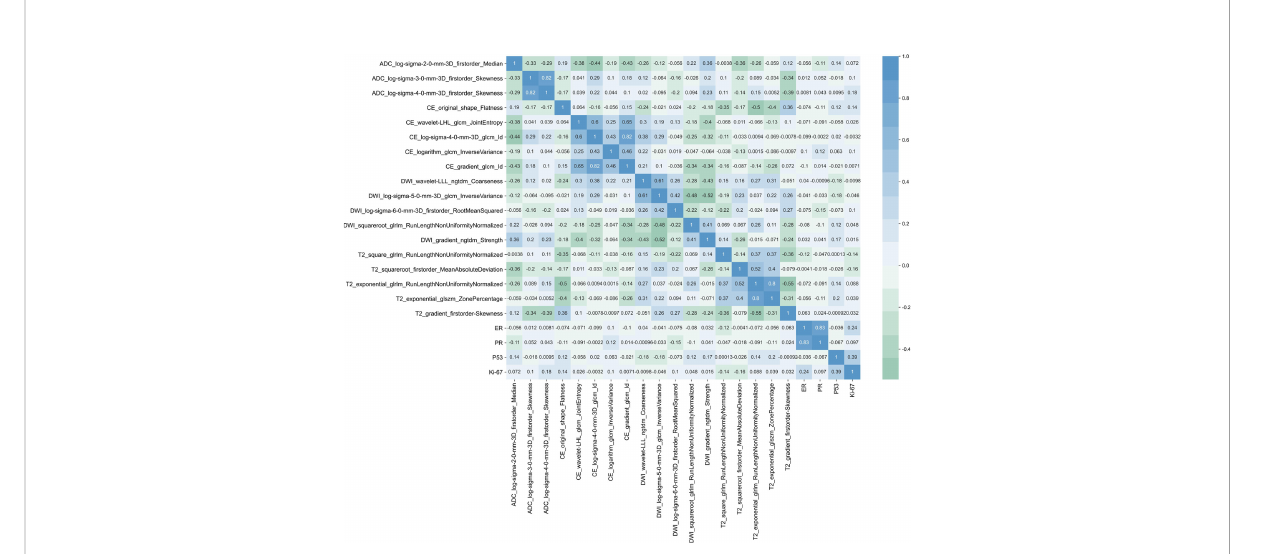
FIGURE 6 Heatmap of the correlations between the selected radiomics features and ER, PR, P53, and